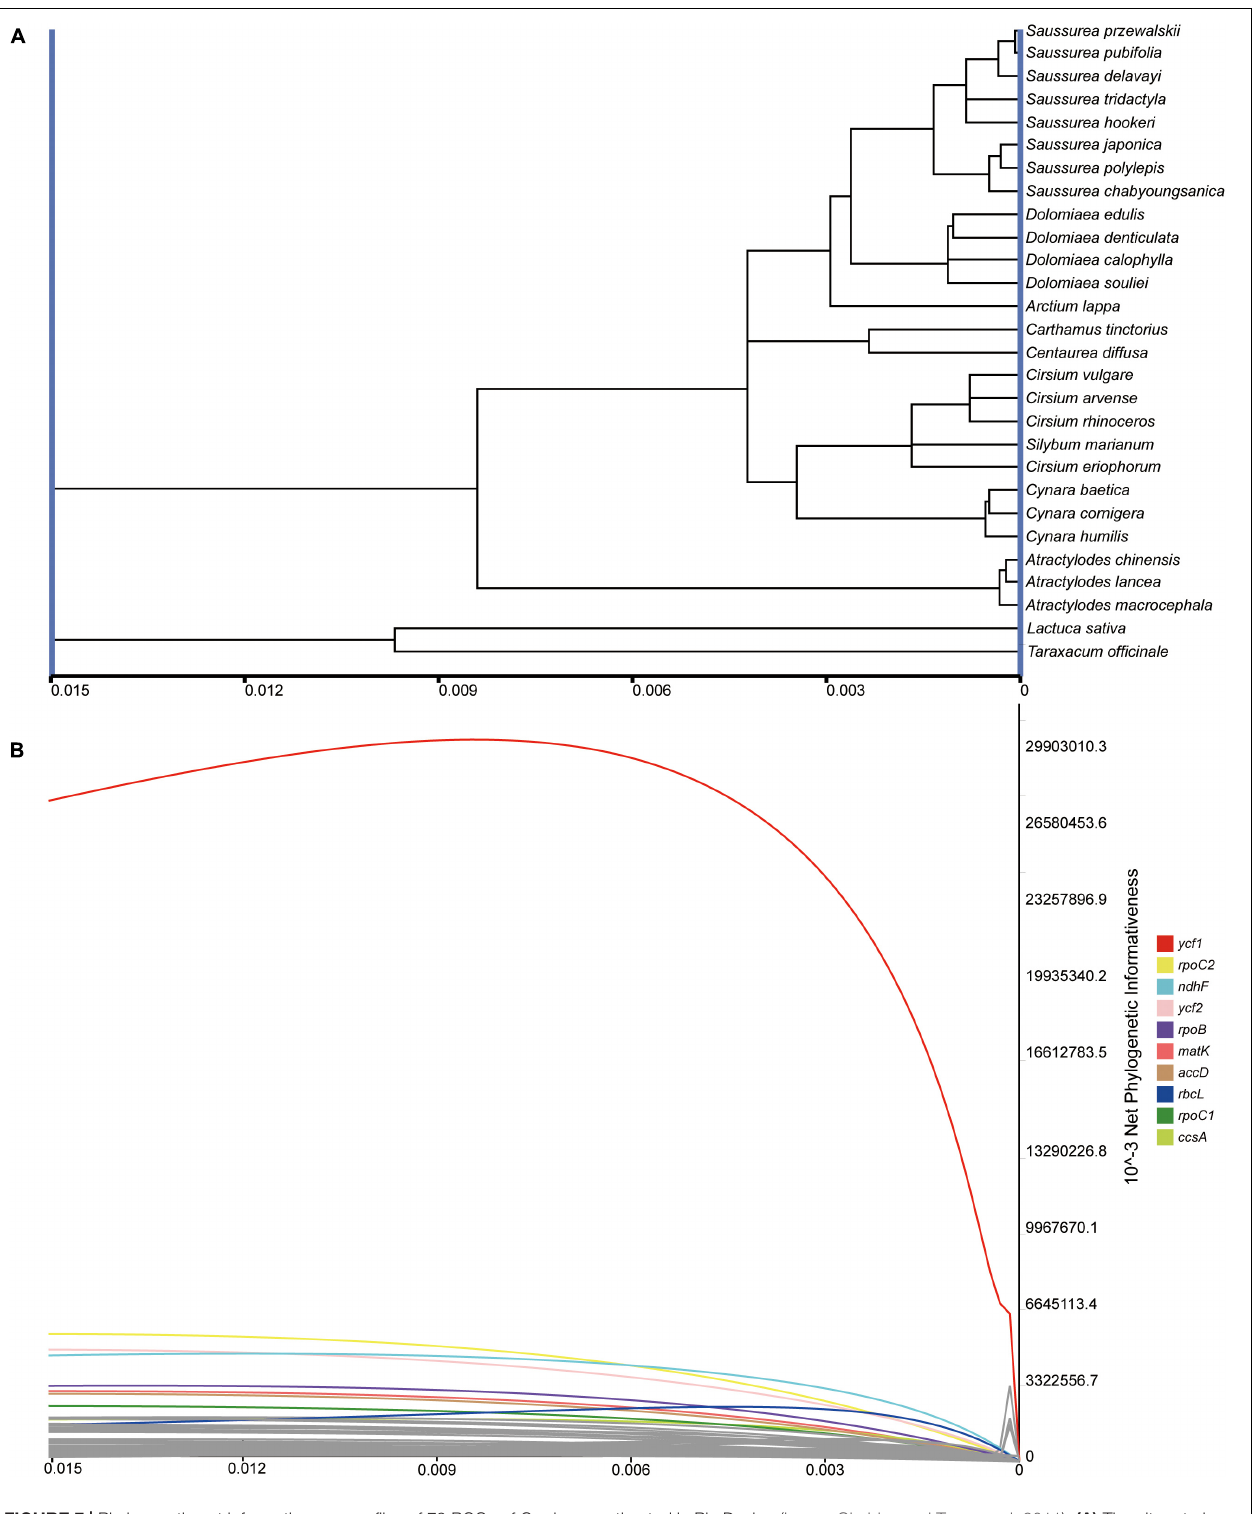
Frontiers in Plant Science |